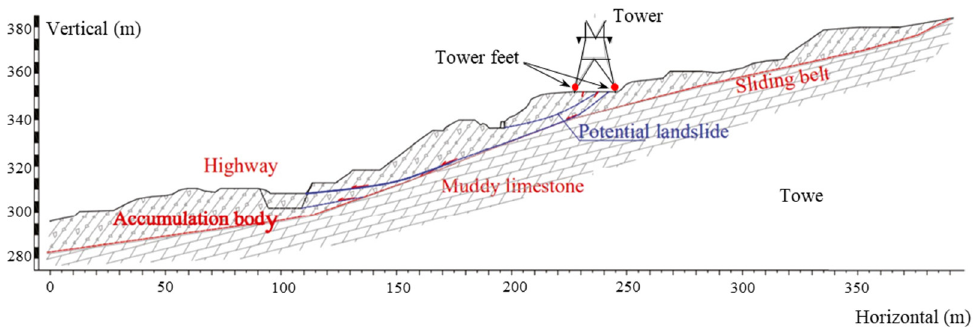
Figure 4. Geological section of Yanzi landslide.